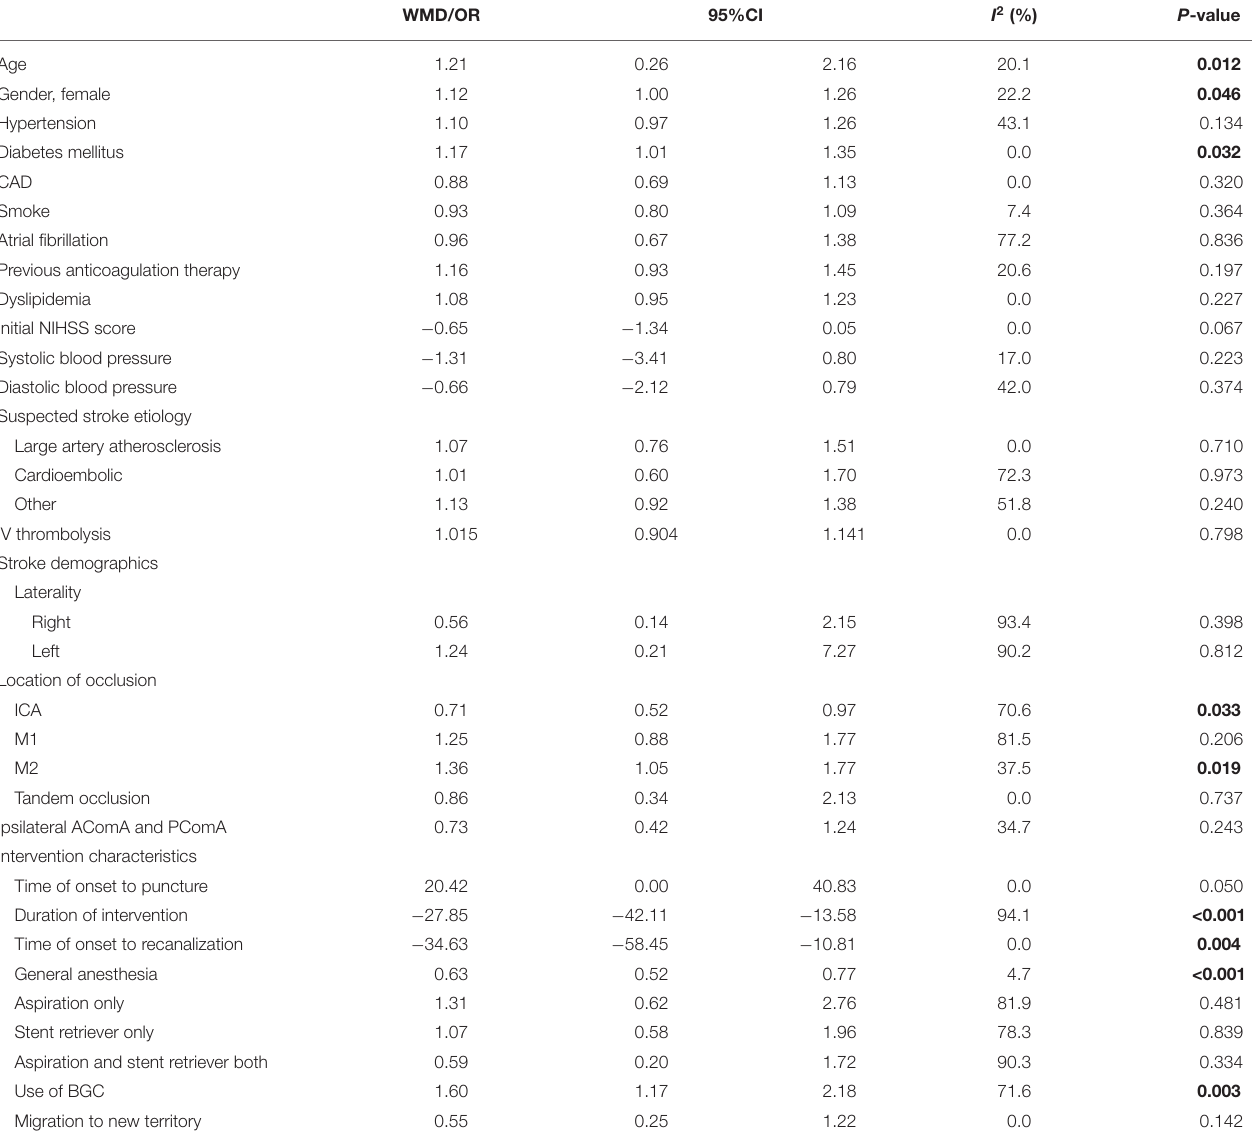
TABLE 2 | Summary of meta-analysis of influencing factors for achieving successful recanalization with